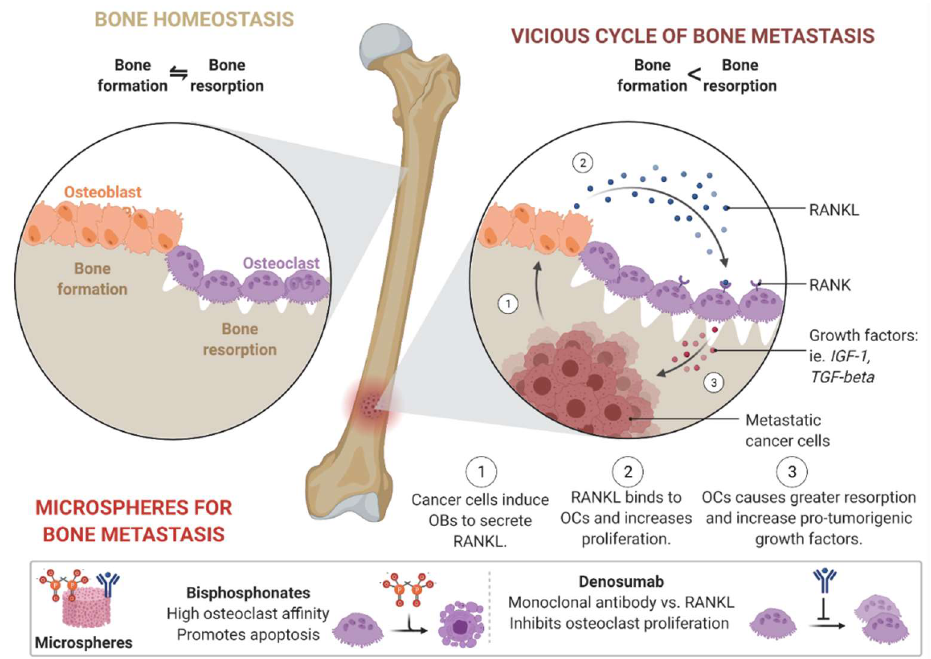
Figure 4. New techniques for the treatment of bone metastasis using the microsphere as a controlled release depot.